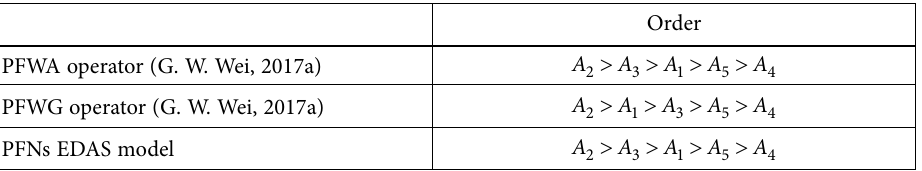
Table 10. Rank of Alternatives by some PFNs aggregation operators